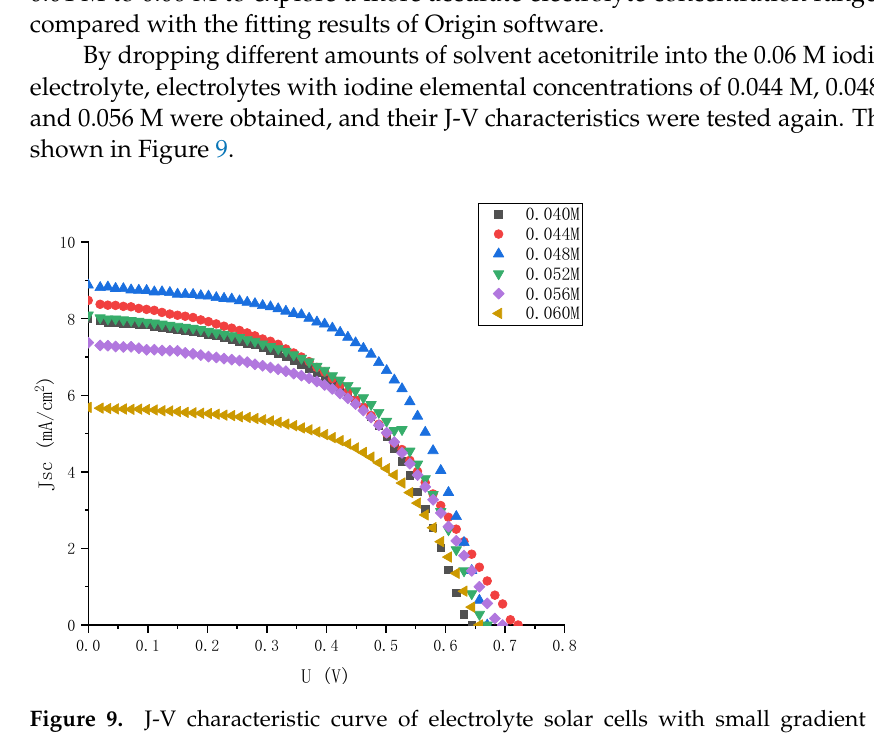
Figure 9. J-V characteristic curve of electrolyte solar cells with small gradient and different iodine concentrations.